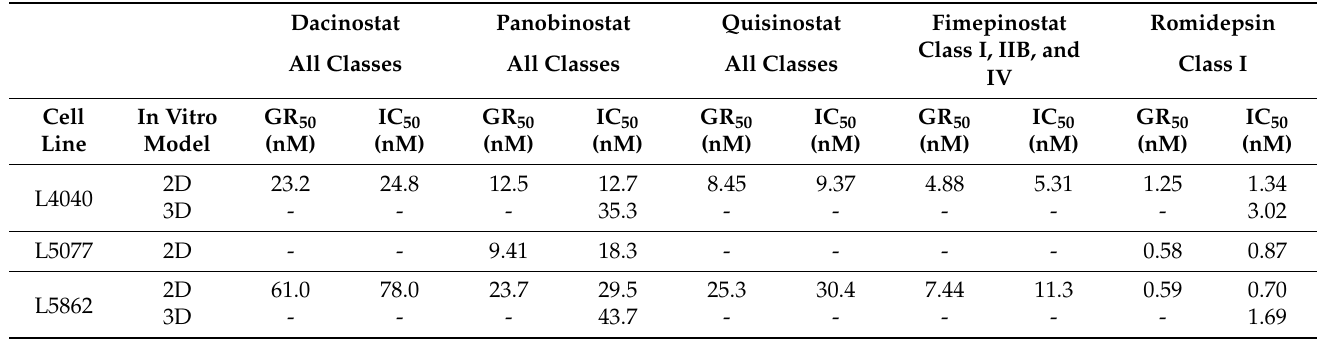
Table 1. GR 50 and IC 50 values after 72 h treatment with HDAC inhibitors in GCTB cell lines. Dacinostat Panobinostat Quisinostat